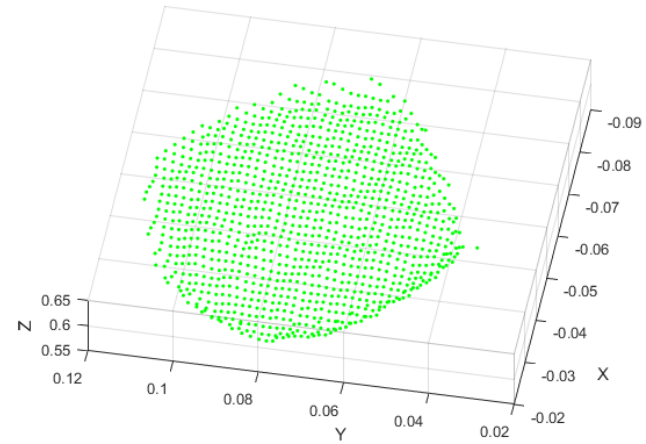
Figure 8. The segmentation 3-D point cloud of soybean leaf from Kinect V2.